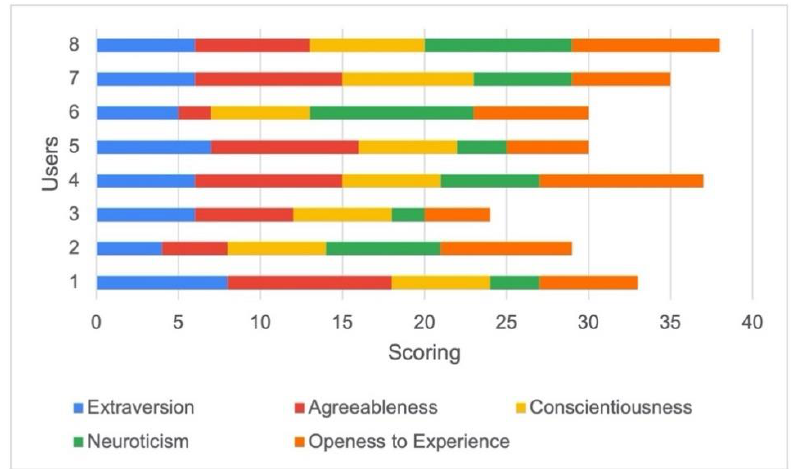
Figure 3. Big Five personality traits of the recruited participants.